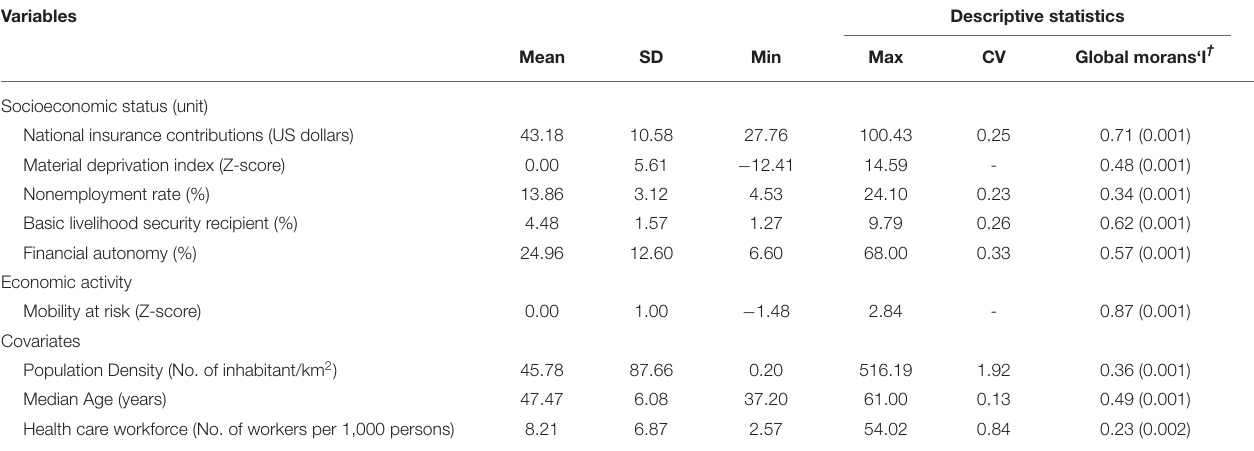
TABLE 2 | Overview of socioeconomic status measures, economic activity variables, and covariates for 229 municipalities in Korea. Variables